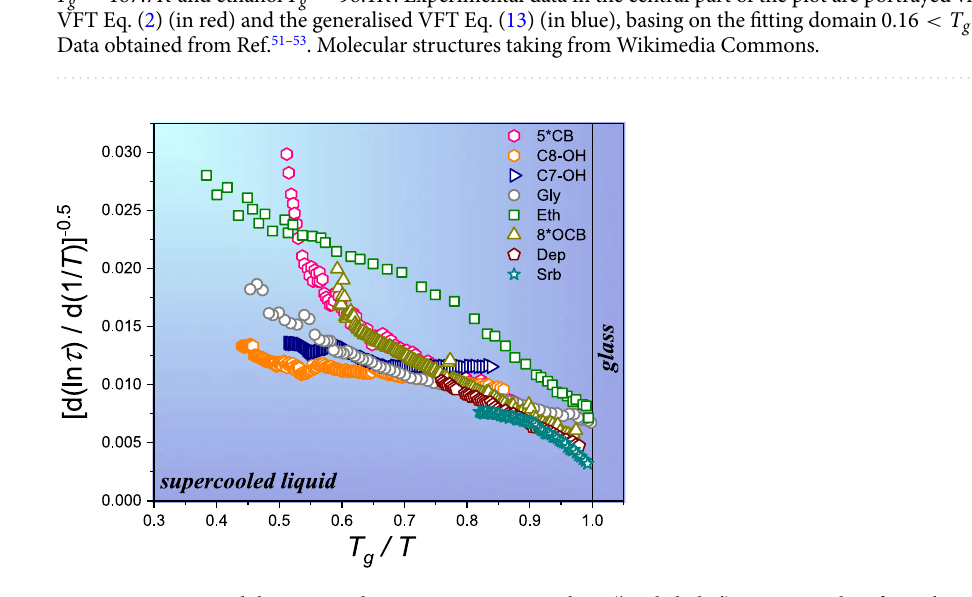
Figure 4. Linearised distortions-distortions sensitive analysis (‘Stickel plot’). Data are taken from the central parts of obtained results. Straight lines denote n = 1 and VFT description correctness. The temperature scale is normalised to T g